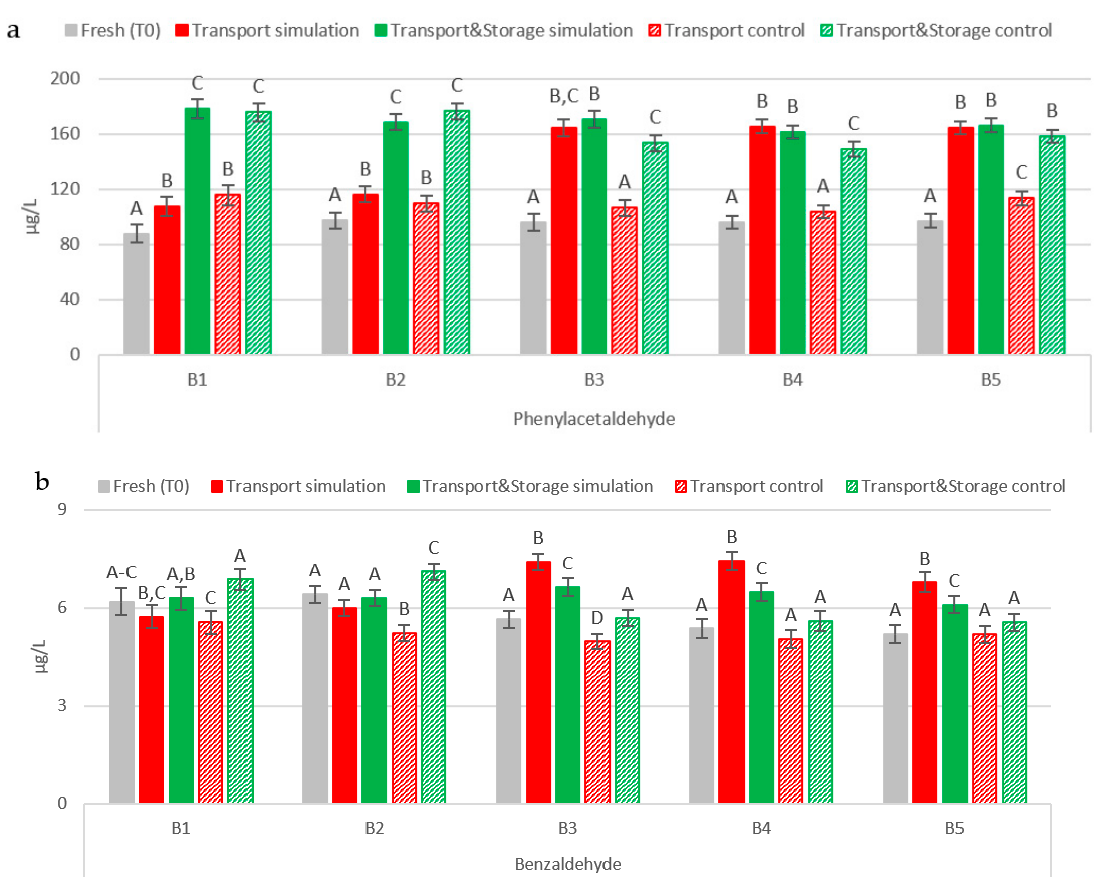
Figure 1. Evolution of Strecker aldehydes under simulated conditions: ( a ) Phenylacetaldehyde; ( b ) Benzaldehyde. The Tukey test was performed for each batch. Different letters represent statistically significant differences ( p < 0.05).